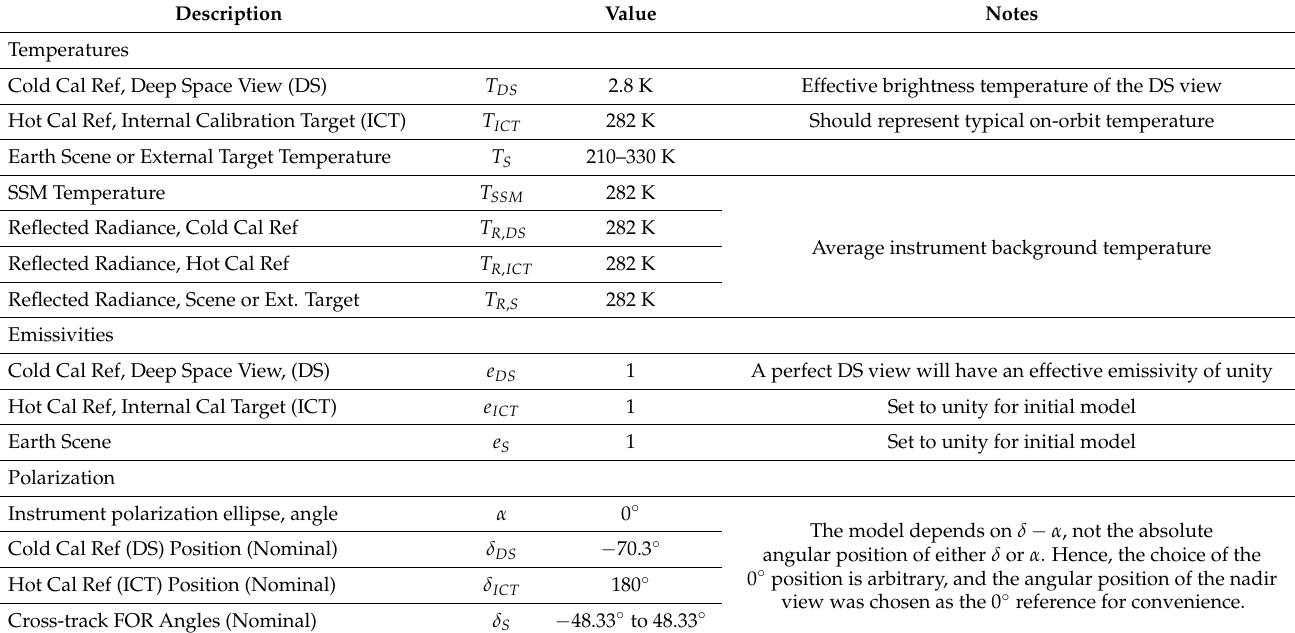
Table 2. Preliminary polarization parameters used for initial